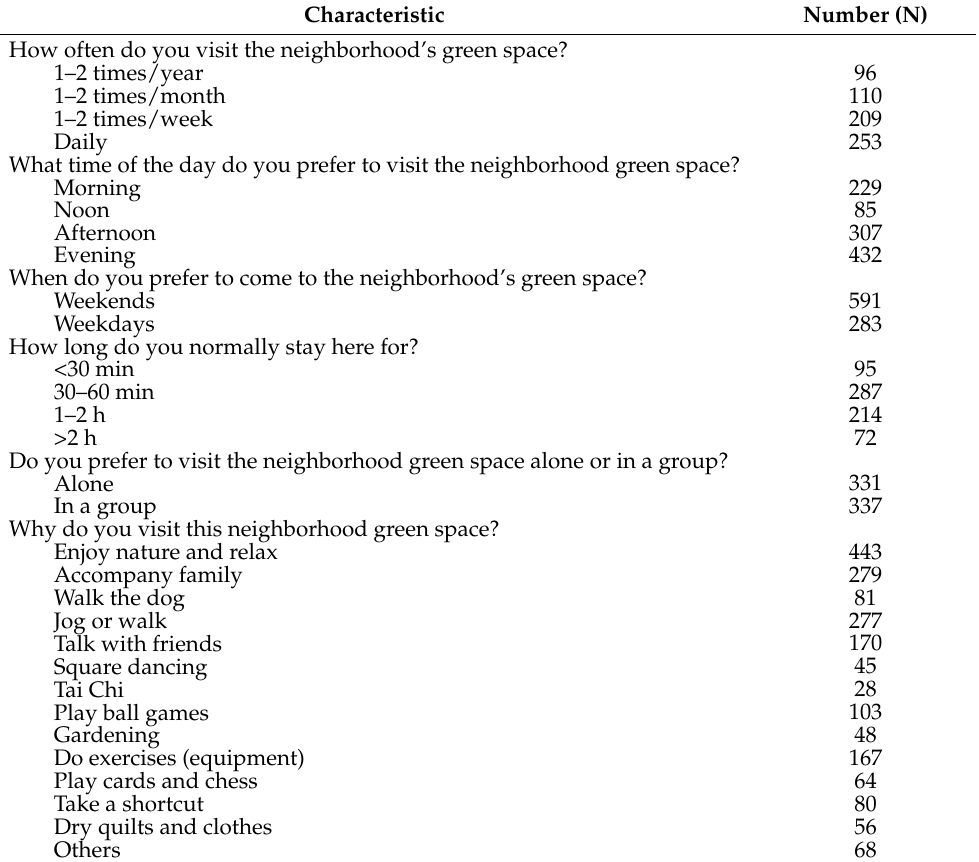
Table 2. User pattern by respondents at an old residential neighborhood’s green space (N = 668).